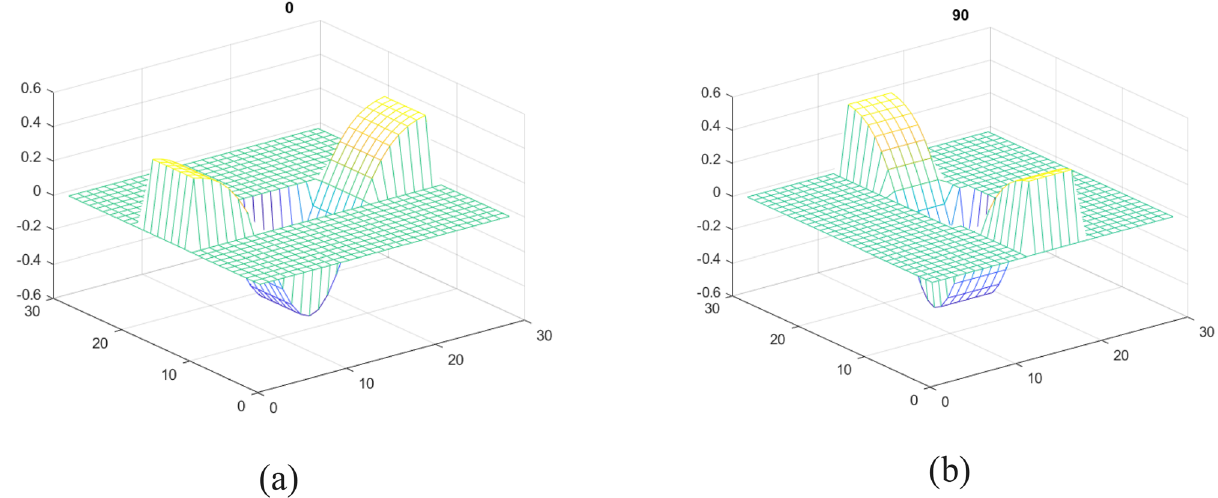
Figure 3. Rotation of matched filters ( a ) kernel with 0° angle ( b ) kernel with 90° Image calibration. HEs emerge at the retina’s vitreous humour, and the black background does not contain any information. Black background misleads the detection process for the HEs at the retina’s rim. Therefore, the illumination of the black background assists in automatic detection and reduces the search space. The median filter is applied on the green channel to suppress the random intensity variations on the black background then the image is binarized to get the retinal mask. The eroded mask is subtracted from the retinal mask to achieve the exact retinal boundary. The hand-crafted image is obtained by adding complimented retinal mask multiplied by the average gray value, retinal periphery, and the enhanced green channel. Figure 2 shows the calibrated image with a bright background where the retinal information is not undermined and is used for feature extraction.